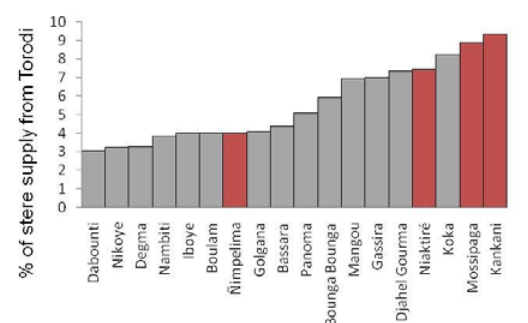
Figure A2.1: Part of firewood supplied by the 18 most productive RMs (Source: traffic survey, Gesforcom